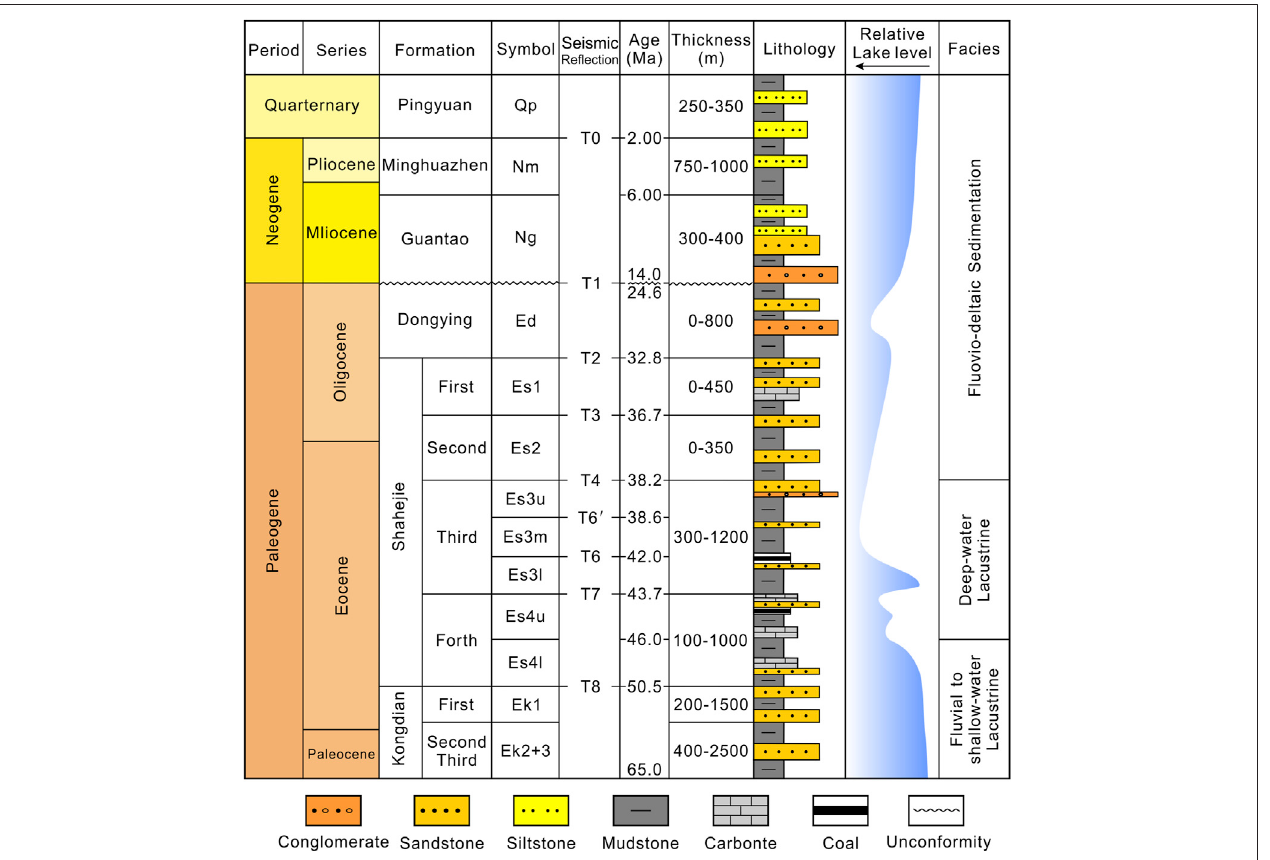
FIGURE 2 | Schematic Cenozoic stratigraphy of the Linnan Sag, showing the symbols, age, thickness, and mainly lithology of each formation.